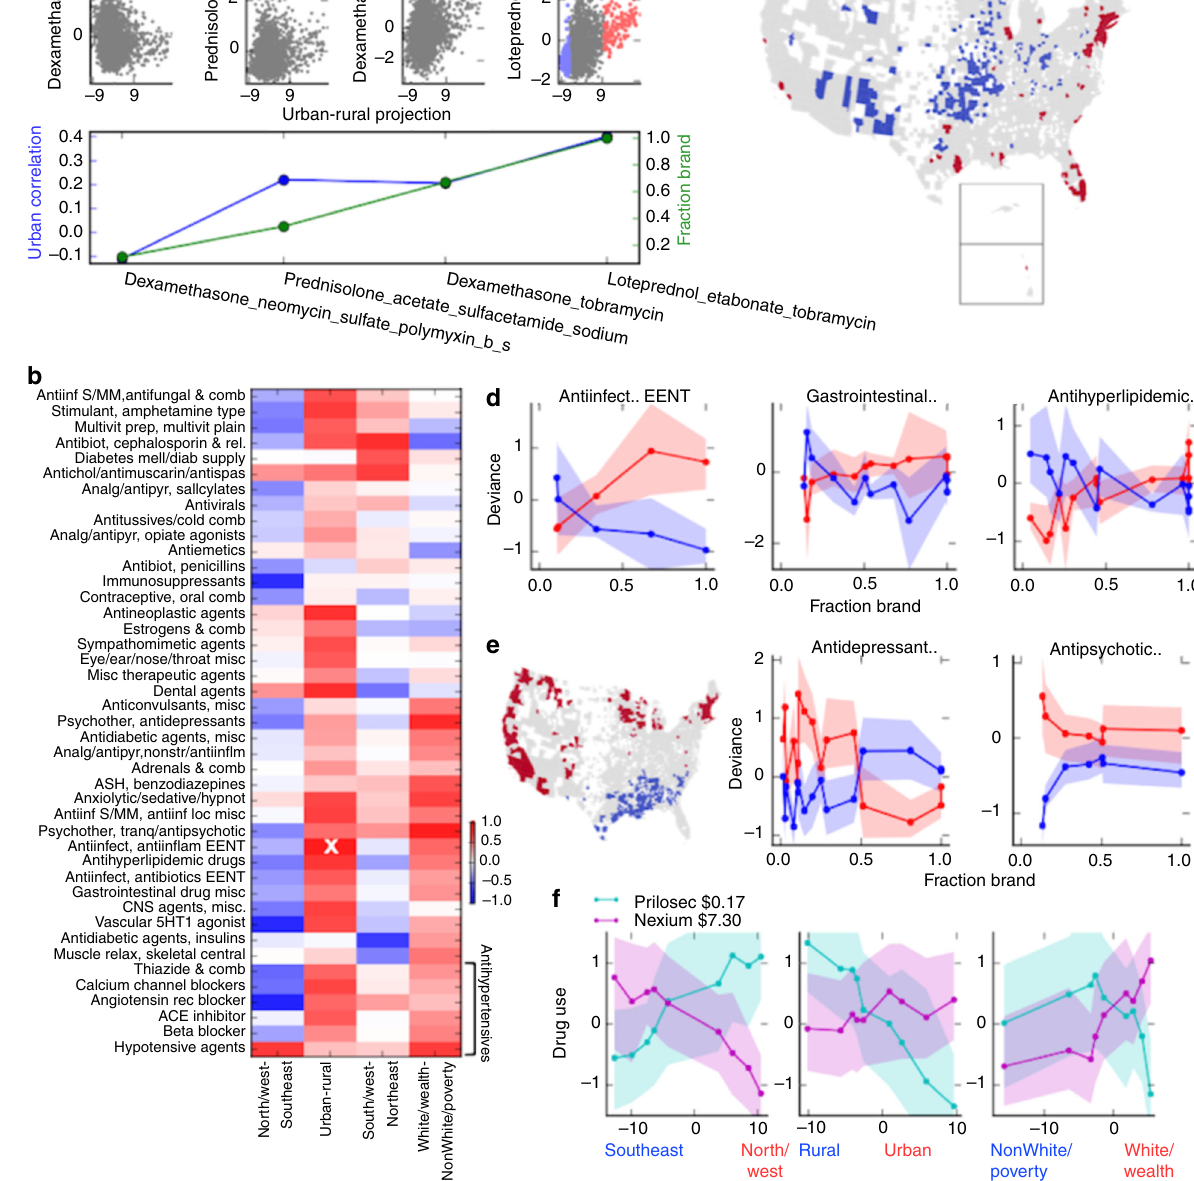
Fig. 5 Correlation of drug price with regional drug preferences. a In the top panel, anti-in fl ammatory eye drops (part of class Antiinfect, Antiin fl am EENT (ears, eyes, nose throat)), are arranged from left to right by fraction generic. Each scatter plot compares county Urban – Rural projection against deviance in the given drug. The correlation (abbreviated, cor) increases with fraction generic: shown for the same drugs in the bottom panel. b The correlation between price and drug preference, for the largest therapeutic classes. The example from part ( a ) is highlighted with a white X. c Urban and rural counties, also highlighted in the rightmost plot in ( a ). The two extreme county groups are contrasted in part ( d ). d In each panel, the points are drugs in a therapeutic class. The drugs are arranged by increasing fraction brand-only ( x axis). Fraction brand is compared with drug deviance values in the Urban (red) and Rural (blue) counties (see c ). Filled regions highlight the 25 – 75 quartiles for use of each drug across each set of counties. The left plot shows the class from ( a ). e Analogous to c / d but for North/West-Southeast, and different drug classes. f Each panel compares use of Prilosec and Nexium across counties projected onto one component. Counties are binned by the component projection. The x axis denotes the component projection, and the y axis shows use of the drugs in those counties. The fi lled regions show 25 – 75 percentile of the deviance values across counties in the